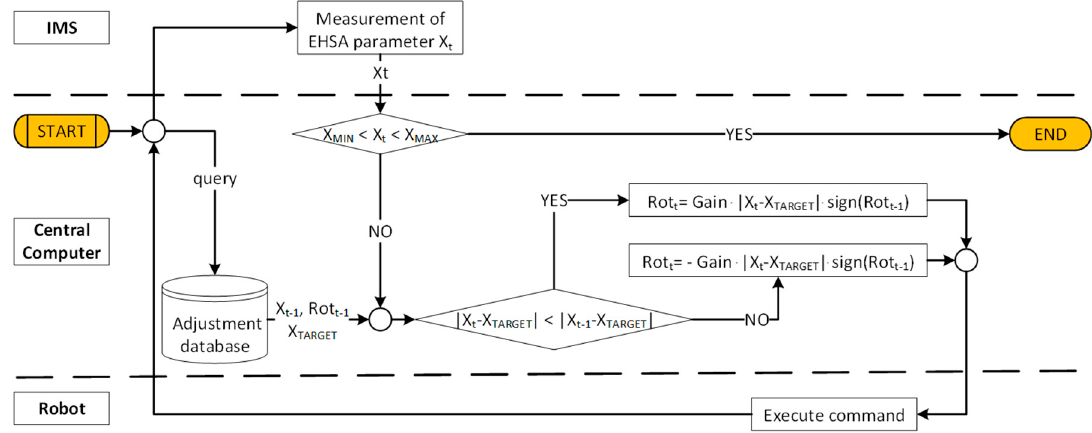
Figure 9. Flowchart reporting the control logic used to perform an automatic adjustment on the servo-actuator.